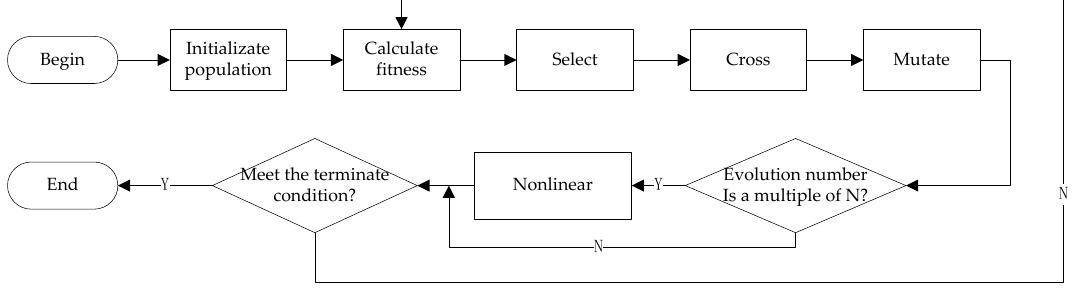
Figure 1. The nonlinear programming-based genetic algorithm (NPGA) flowchart.